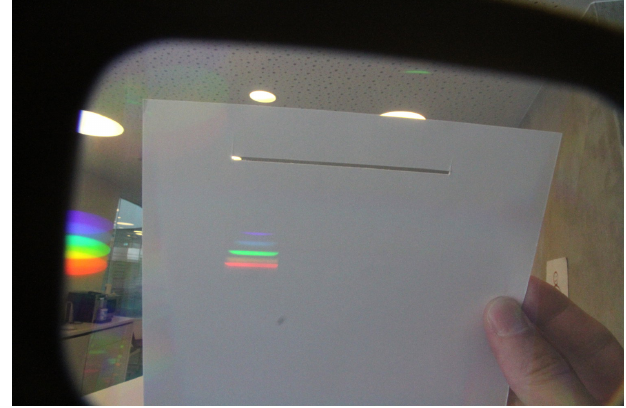
Fig. 17.— One of the light sources masked by a slit, and imaged through the same dispersive element